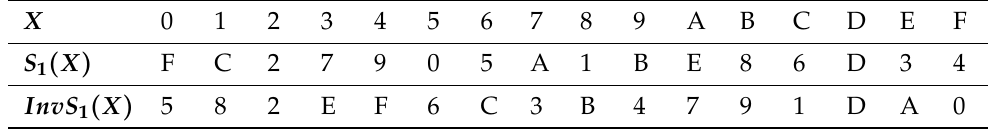
Table 2. Second S-Box of Serpent defined as S 1 ( X ) .